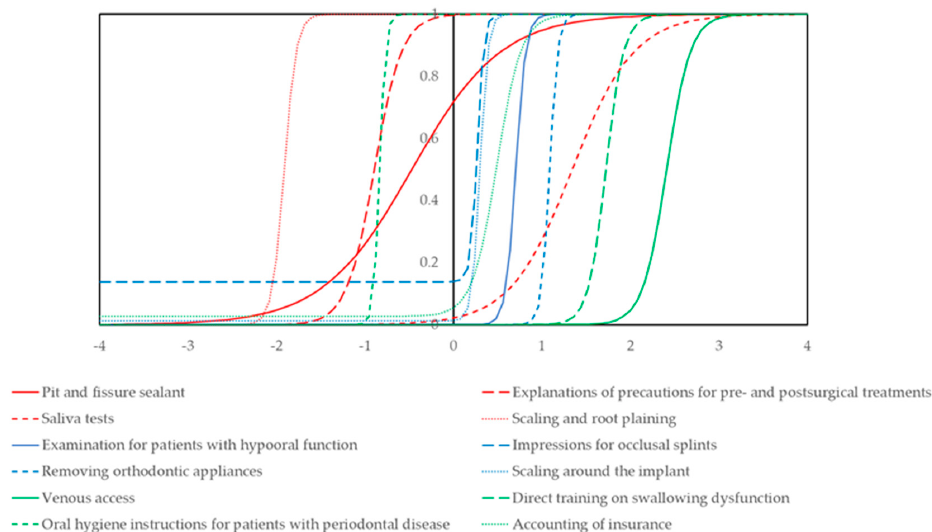
Figure 1. Item response curve of representative dental hygienists’ daily tasks. From all dental hygienists’ daily work- related tasks, the items that had the highest item information in each category are presented. All of the item response and information curves of the daily work-related tasks are shown in Figure S1.